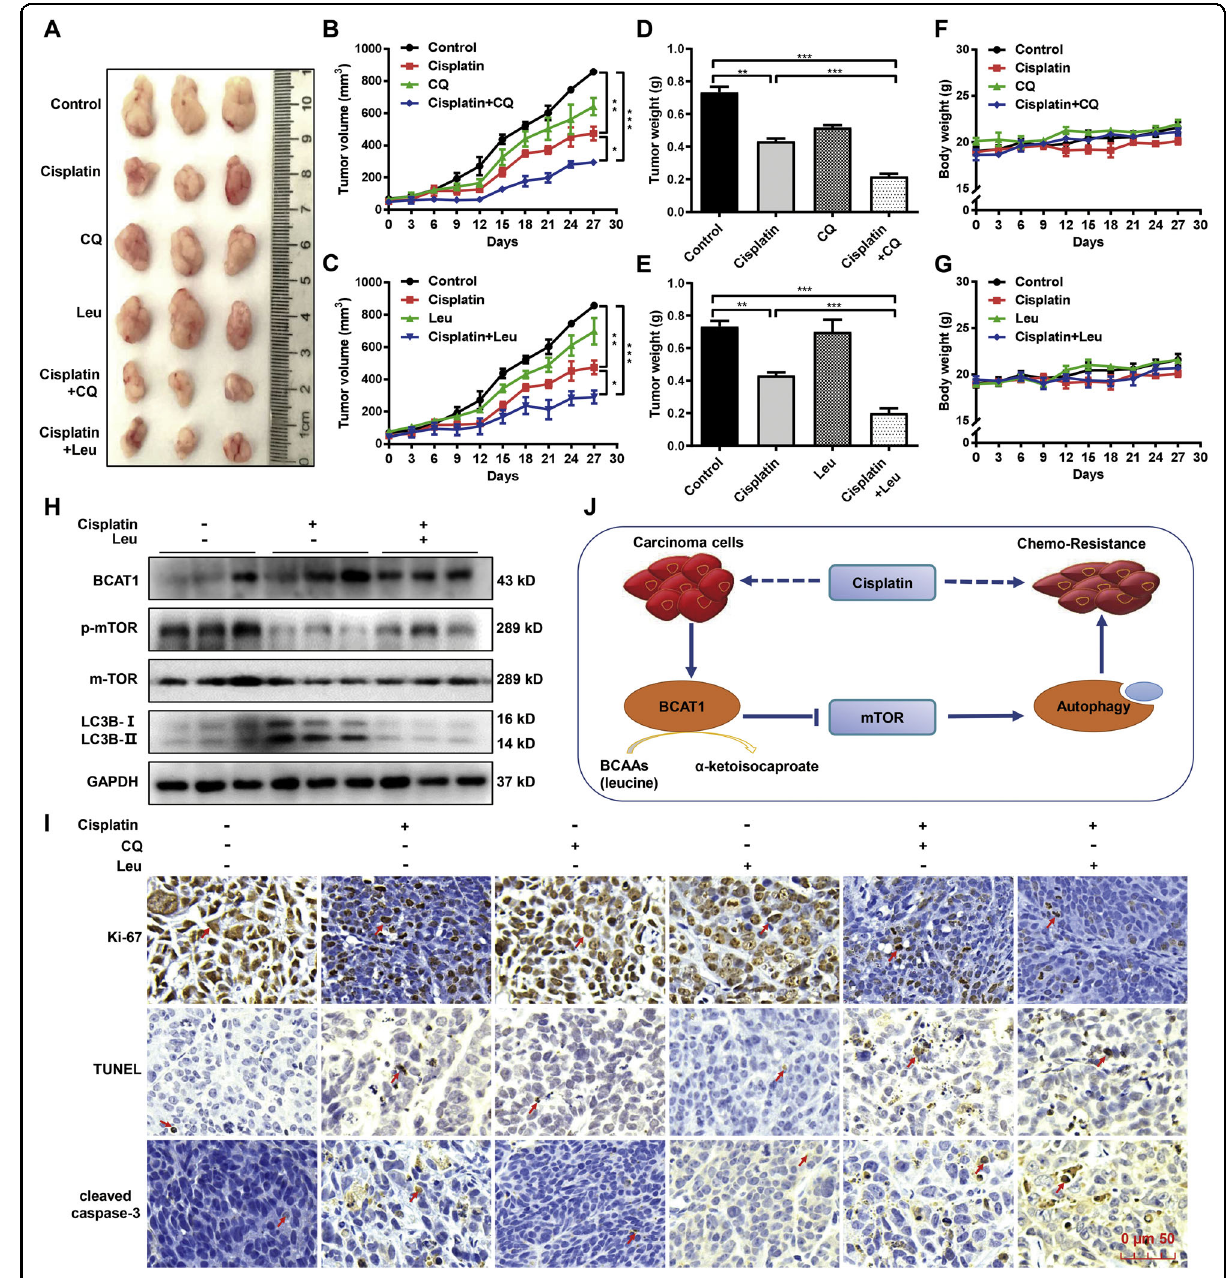
Fig. 7 Administration of leucine (Leu) or chloroquine (CQ) increases cisplatin sensitivity in vivo. A Representative images of the xenograft tumors after the therapy ( n = 5). Hela xenograft mice were treated with cisplatin, CQ, Leu, cisplatin plus CQ, or cisplatin plus Leu. B , C Tumor volume was measured and calculated every 3 days ( n = 5). D , E The fi nal tumor weight was measured ( n = 5). F , G The bodyweight of mice was measured every 3 days ( n = 5). H The protein expression levels of BCAT1, LC3B-I/II, mTOR, and phosphorylated mTOR were examined in the tumor tissues by Western blot. I IHC staining of Ki-67 and cleaved caspase-3 and TUNEL assay. The arrow represents a positive signal. Scale bars: 50 μ m. (J) A schematic of the molecular mechanism. * P < 0.05, ** P < 0.01, *** P <